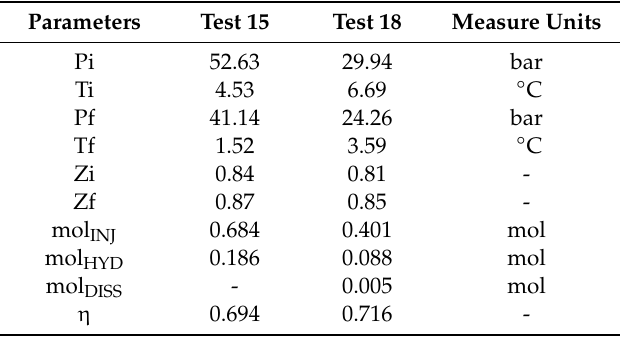
Table 9. Parameters related to Test 15 (with CH 4 ) and Test 18 (with CO 2